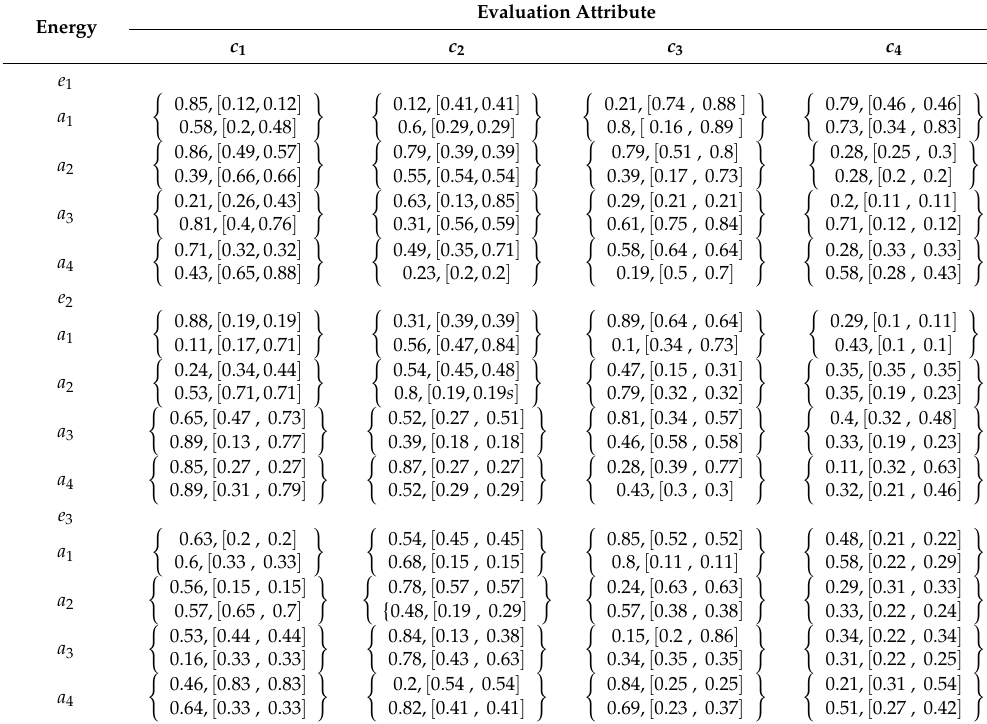
Table 2. Interval-valued probabilistic hesitant fuzzy set (IVPHFS) based preference information for di ff erent DMs.